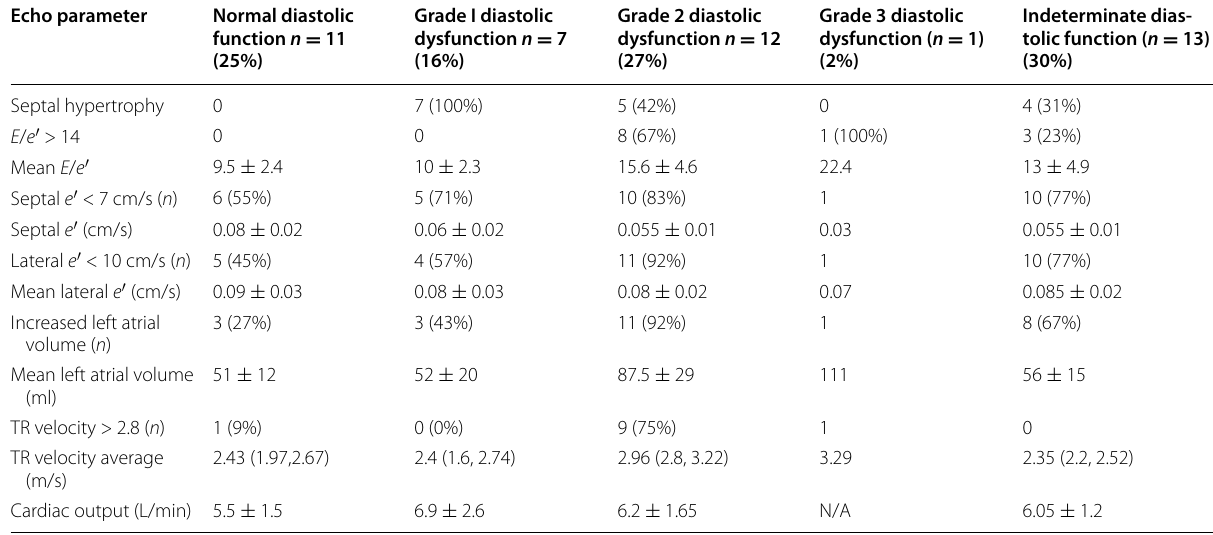
Diastolic dysfunction assessed by 2016 ASE/EACVI